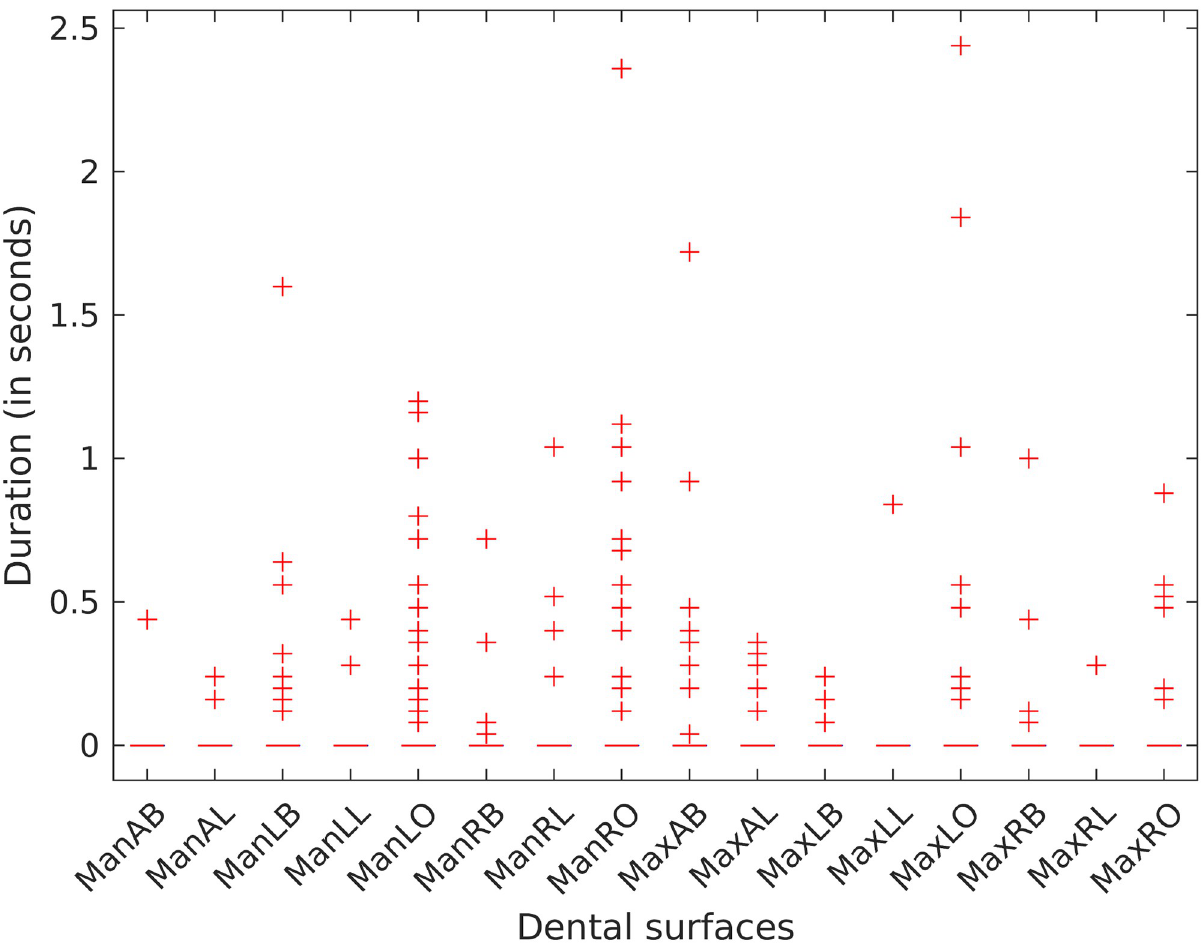
Fig 7. Episodes of excessive brushing pressure by region. Occlusal surfaces were most frequently brushed with excessive